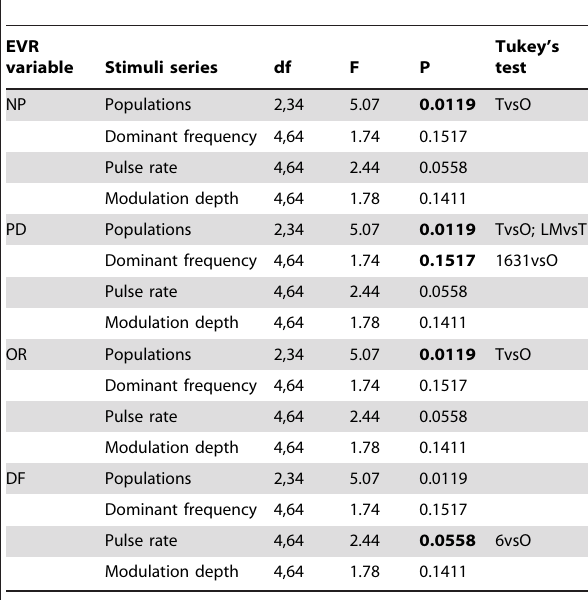
Table 5. Repeated measures GLMs and Tukey’s test for EVRs variables (NP, DP, OR and DF) within four series of stimuli presented to males from the Osorno population of P. thaul